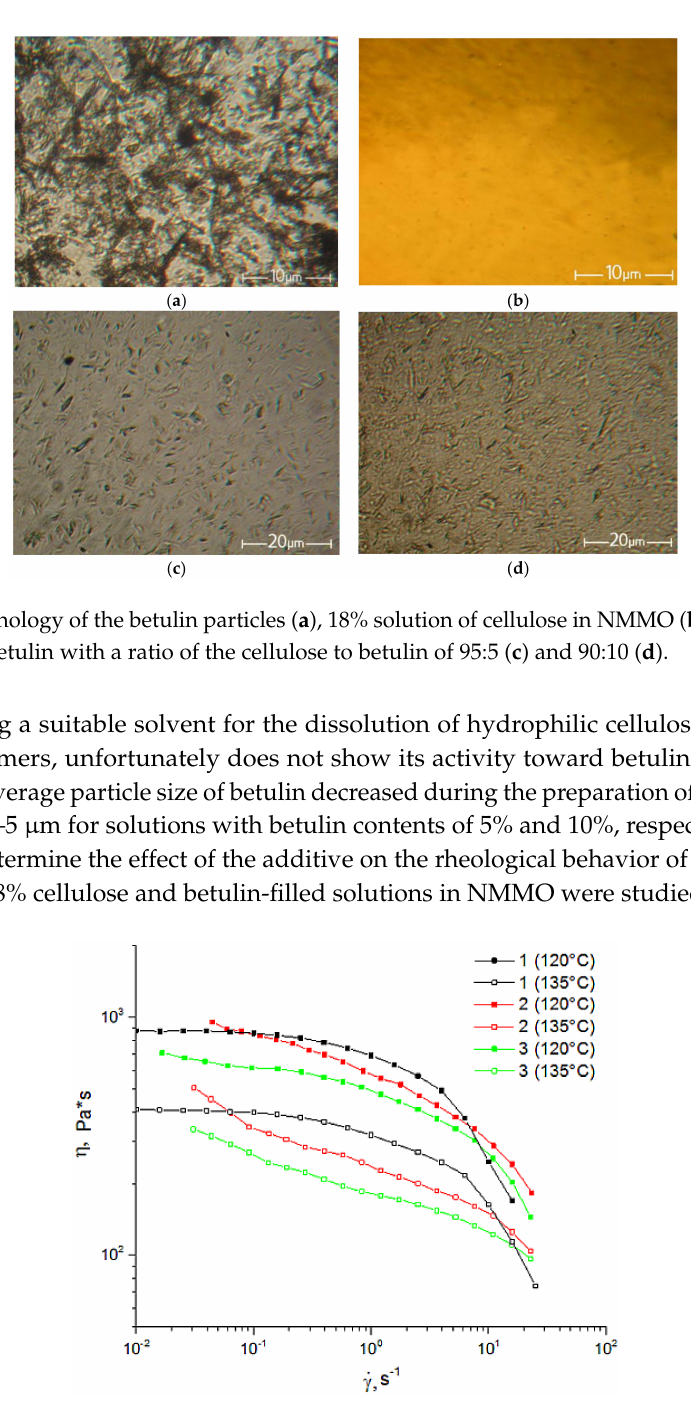
Figure 4. Flow curves of 18% mixtures of cellulose solutions at 120 ◦ C and 135 ◦ C with different contents of betulin (in %): (1) 0%; (2) 5%; (3)